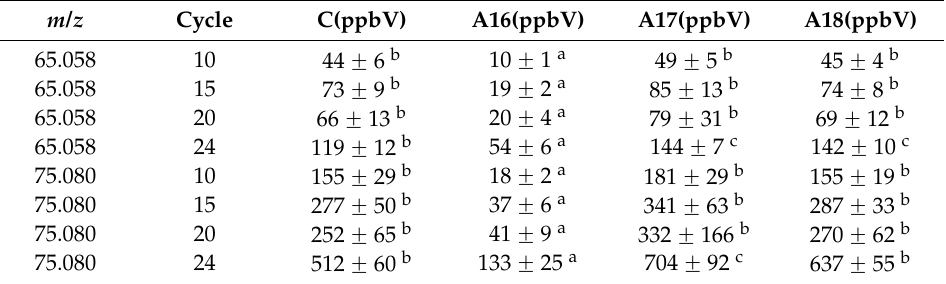
Table 1. PpbV variation for the mass peak m / z 65.059 and m / z 75.080 corresponding to the cycles 10, 15, 20, and 24 (leavening process driven by S. cerevisiae bakery starter cultures C, A16, A17, and A18). m/z Cycle